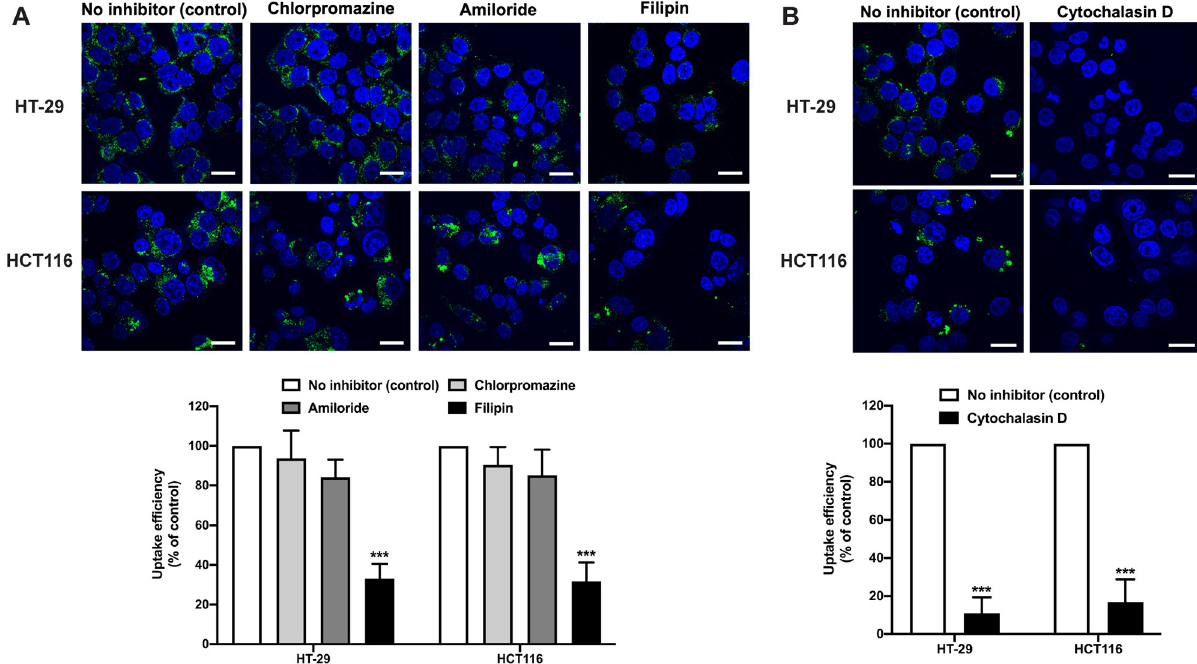
Fig 4. The inhibition of FDNVs internalization in colorectal cells. (A) HT-29 and HCT116 cells were pretreated with chlorpromazine, amiloride, and filipin for 1 h and then incubated with PKH67-label FDNVs (green) for an additional 3 h in the presence of the inhibitors. (B) HT-29 and HCT116 cells were pretreated with cytochalasin D for 1 h and then incubated with PKH67-label FDNVs for an additional 2 h in the presence of the inhibitor. Cells were then fixed and stained with DAPI (blue). The green fluorescence intensity of FDNVs was determined by ImageJ software. Bar graphs show the uptake efficiency of FDNVs in HT-29 and HCT116 cells. The values are presented as means ± SD of three independent experiments in duplicate. ��� P < 0.001 (one-way ANOVA). Scale bar = 10 μ